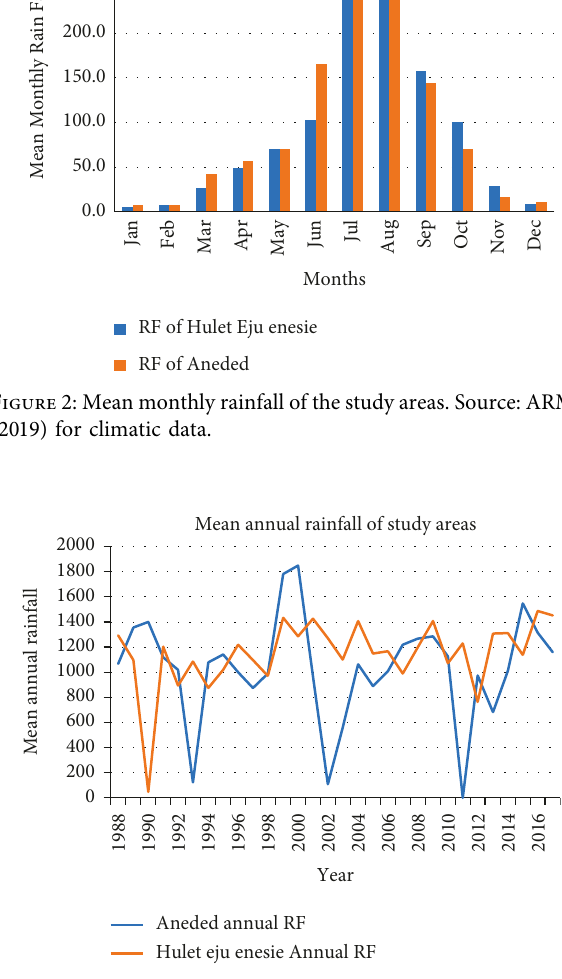
Figure 3: Mean annual rainfall of the study areas. Source: ARMA (2019) for climatic data.